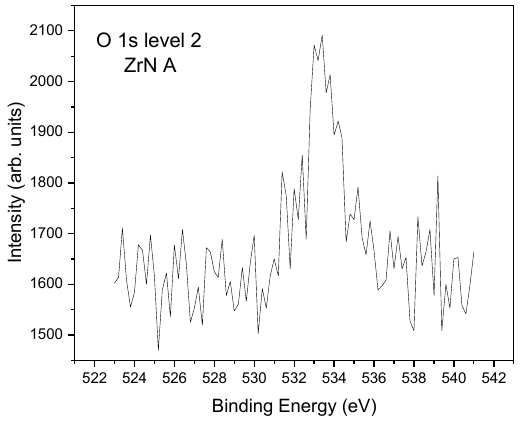
Figure 2. Oxygen contamination in sample ZrN A in-depth level 2.